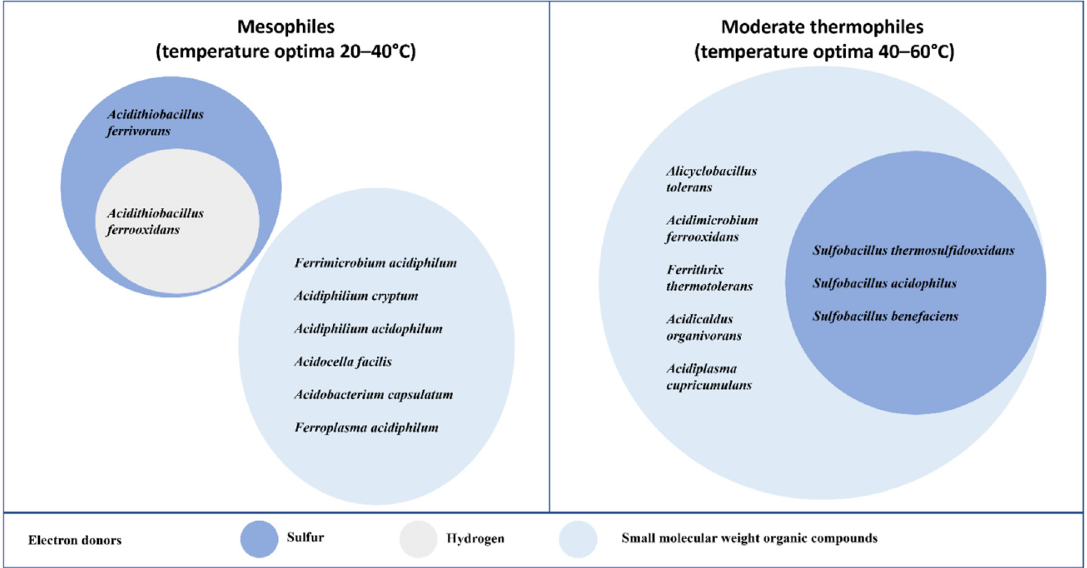
Figure 1. Acidophilic microorganisms catalyzing the dissimilatory reduction of ferric iron to ferrous. Adapted with permission from Johnson [28], published by Springer Netherlands, 2010.